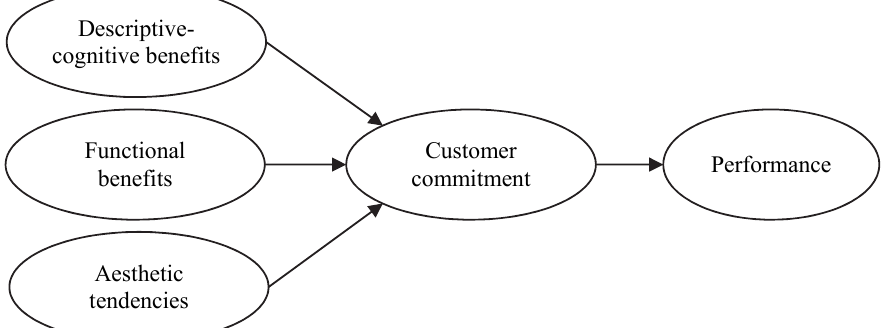
Fig. 1. Conceptual model of the research based on the study accomplished by Park et al. (2013)